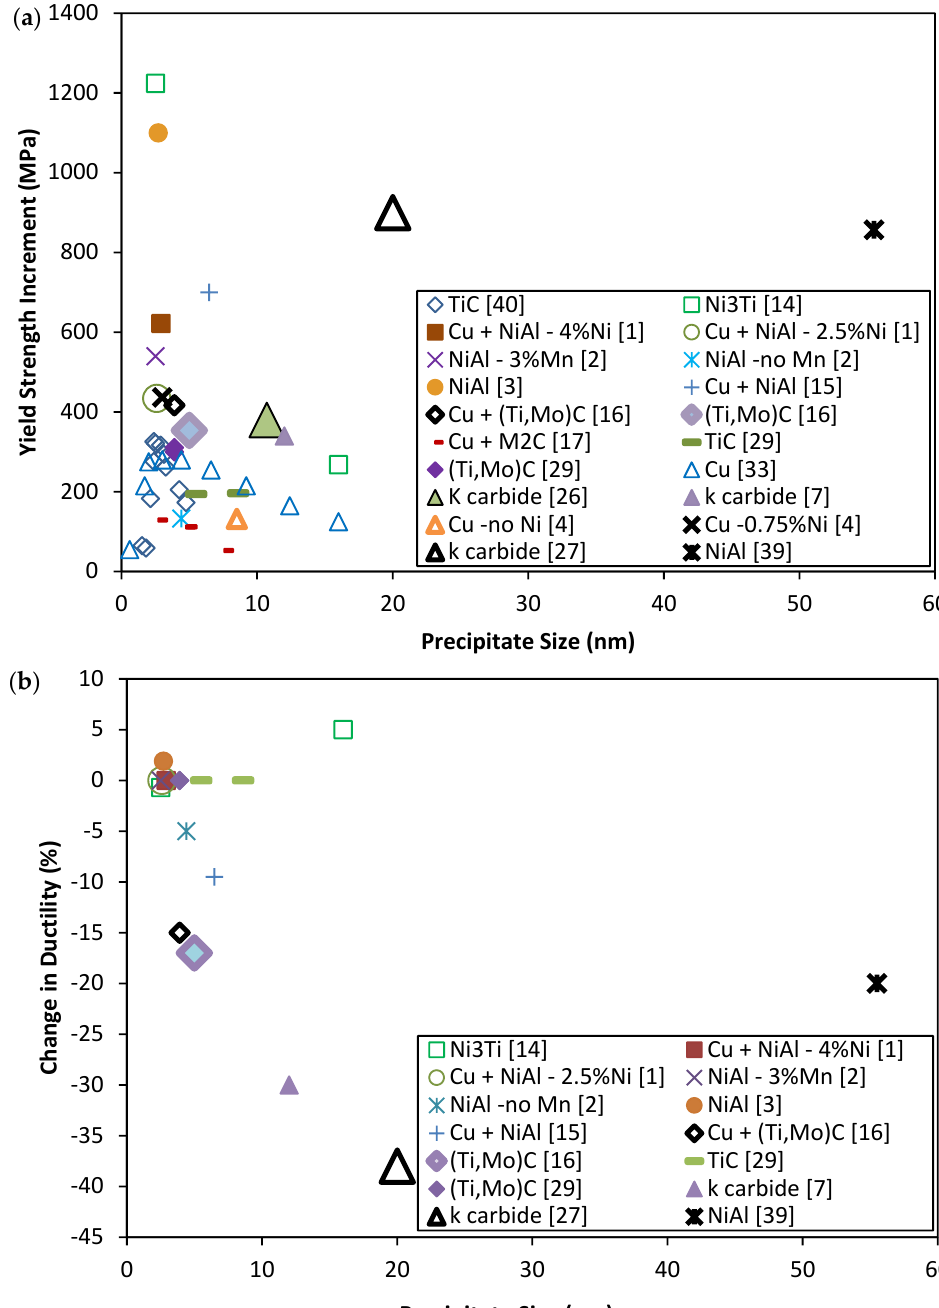
Figure 3. A compilation of ( a ) yield strength increment and ( b ) ductility change against precipitate size of various precipitate strengthened steels. The diameter or the thickness is taken as the size of the precipitates.